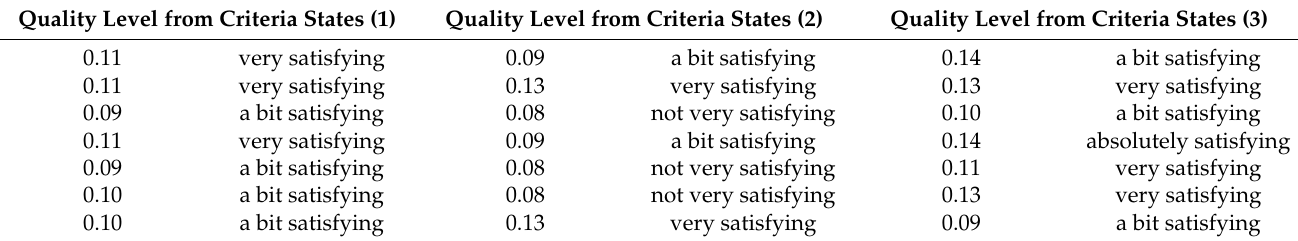
Table 2. Quality levels of PV and initial customers’ satisfaction. Own